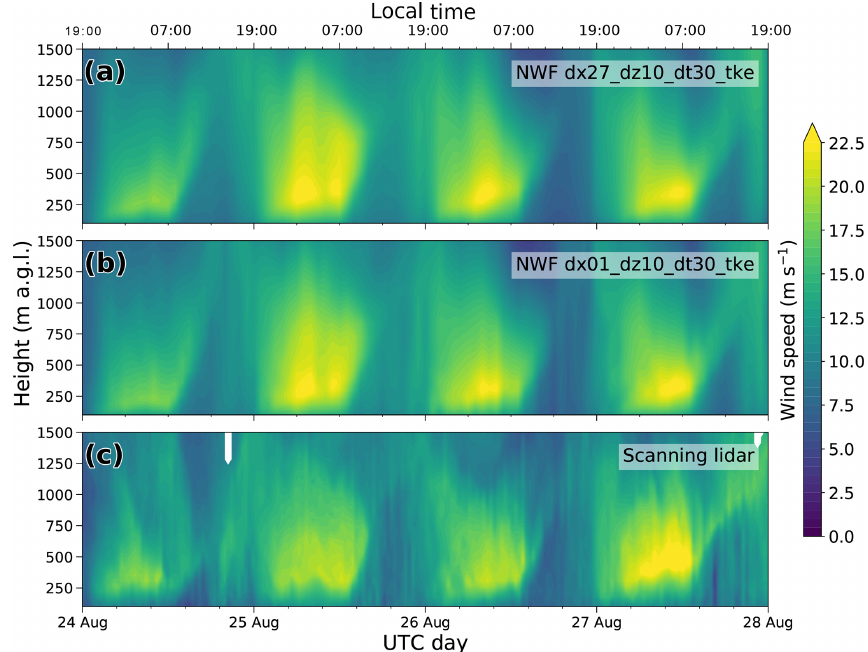
Figure 3. Time–height cross sections comparing wind speed from (a) the no wind farm (NWF) run of the dx27_dz10_dt30_tke simulation with (b) the NWF run of dx01_dz10_dt30_tke , and (c) the scanning lidar observations.